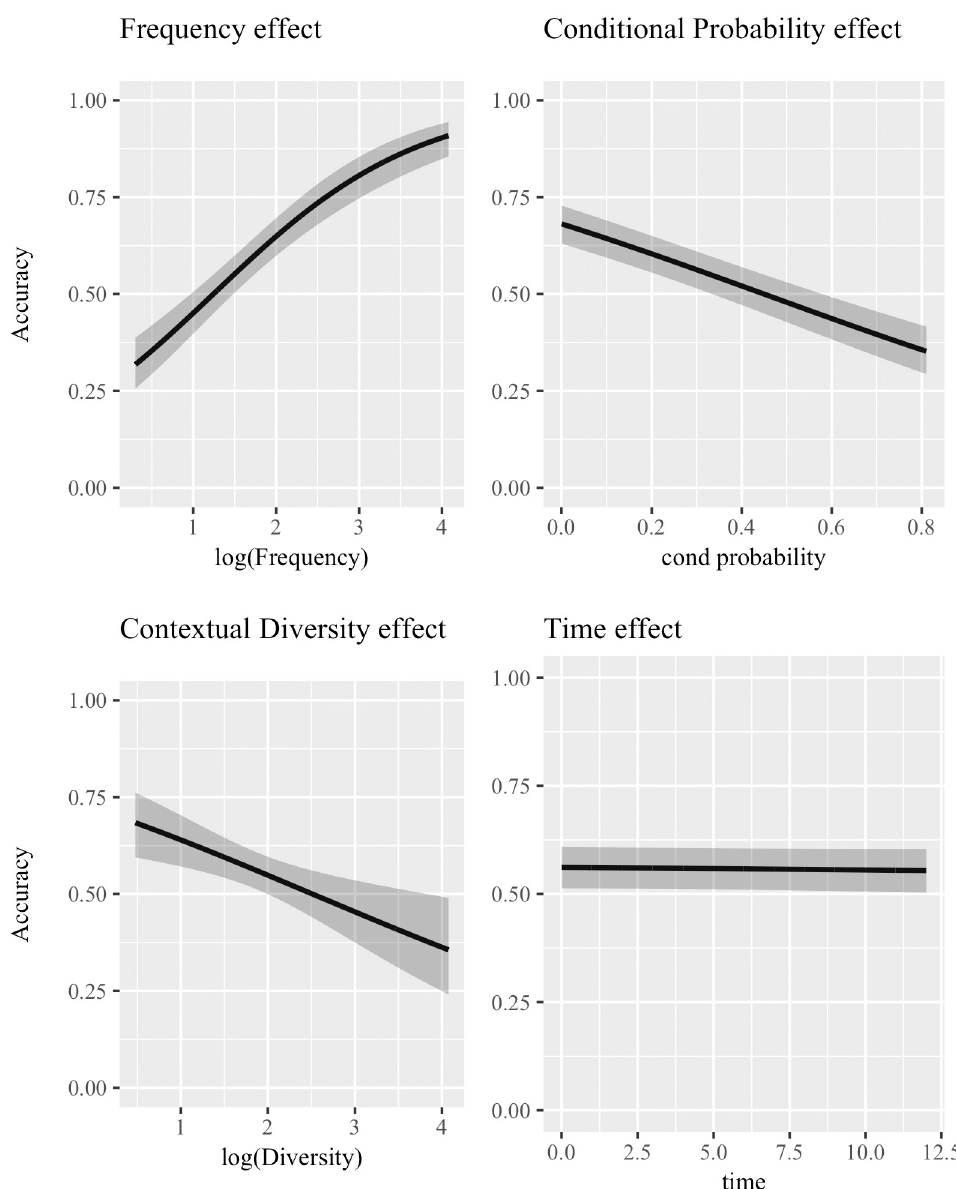
Fig 5. Logistic mixed-effect model including all predictors—Numeric overlap distance. Graphical representation of the effects arising from the logistic mixed-effect mode fitted considering all significant predictors at once and accuracy achieved using numeric overlap to retrieve nearest neighbors as the dependent variable. 95% confidence bands are shown for each effect, and predictors are ordered according to how much they improve the model fit (first top-left, then top-right, bottom-left, and